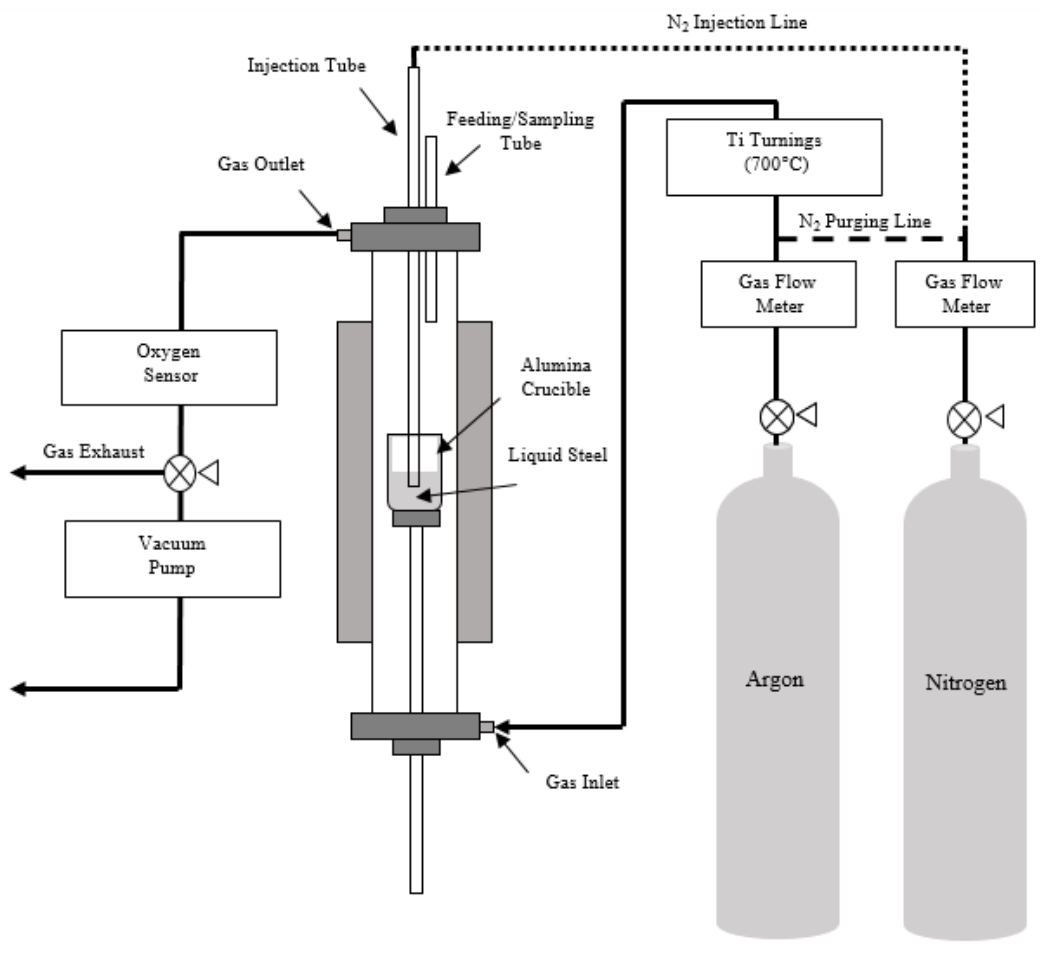
Figure 1. Schematic diagram of the experimental set-up used in this study. Table 1. Experimental steps.